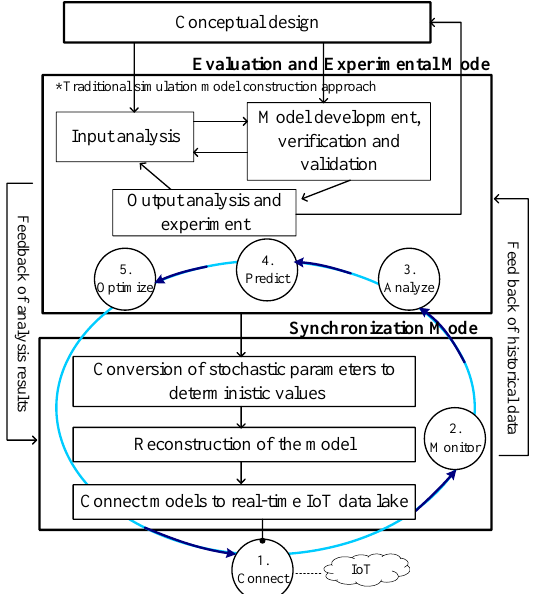
Figure 3. Framework for construction of a DT-oriented simulation model.